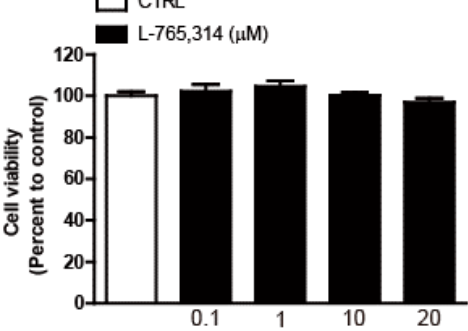
Figure 3. Effect of L-765,314 on cell viability. Mel-ab cells were treated with 0.1–20 μ M L-765,314 for 48 h and cell viability was examined by MTT assay. 48 h and cell viability was examined by MTT